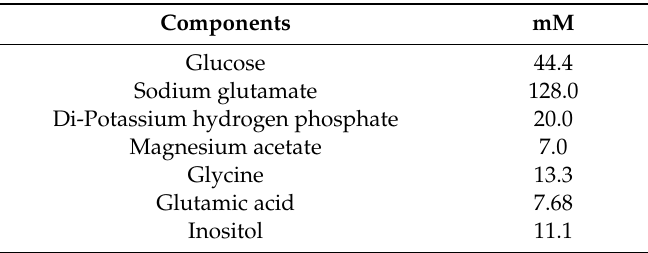
Table 1. Chemical composition of Tselutin